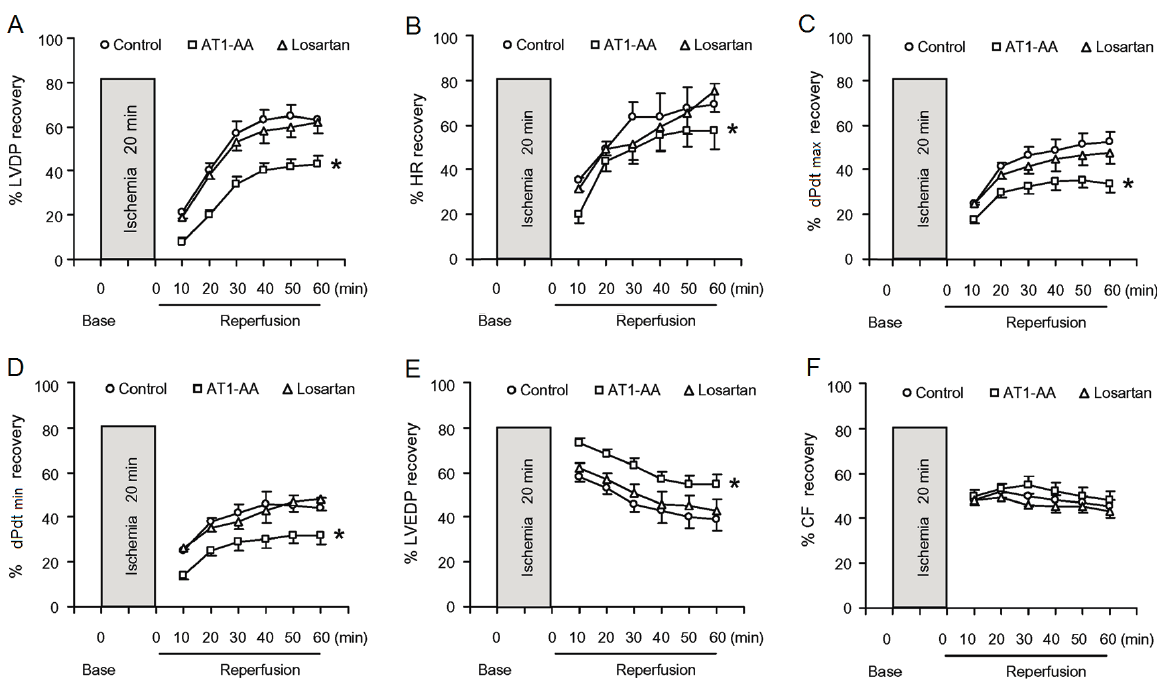
Figure 2. Effect of AT1-AA exposure on post-ischemic recovery of LV function ( A – E ) and coronary flow ( F ). Hearts obtained from the maternal rats exposed to either normal saline or AT1-AA (titer 1:640 0.1 mL/kg) at gestation days 13 and 14 were subjected to 20-min ischemia and 60-min reperfusion in the Langendorff preparation. LVDP: left ventricular or dP/dt : the maximal rates of pressure rise developed pressure; HR: heart rate; dP/dt max min or fall; LVEDP: left ventricular end diastolic pressure; CF: coronary flow; Con: control group; AT1-AA: AT1-AA group; Los: AT1-AA + losartan group. * p < 0.05 compared with control group for the entire curve. n = 6 per